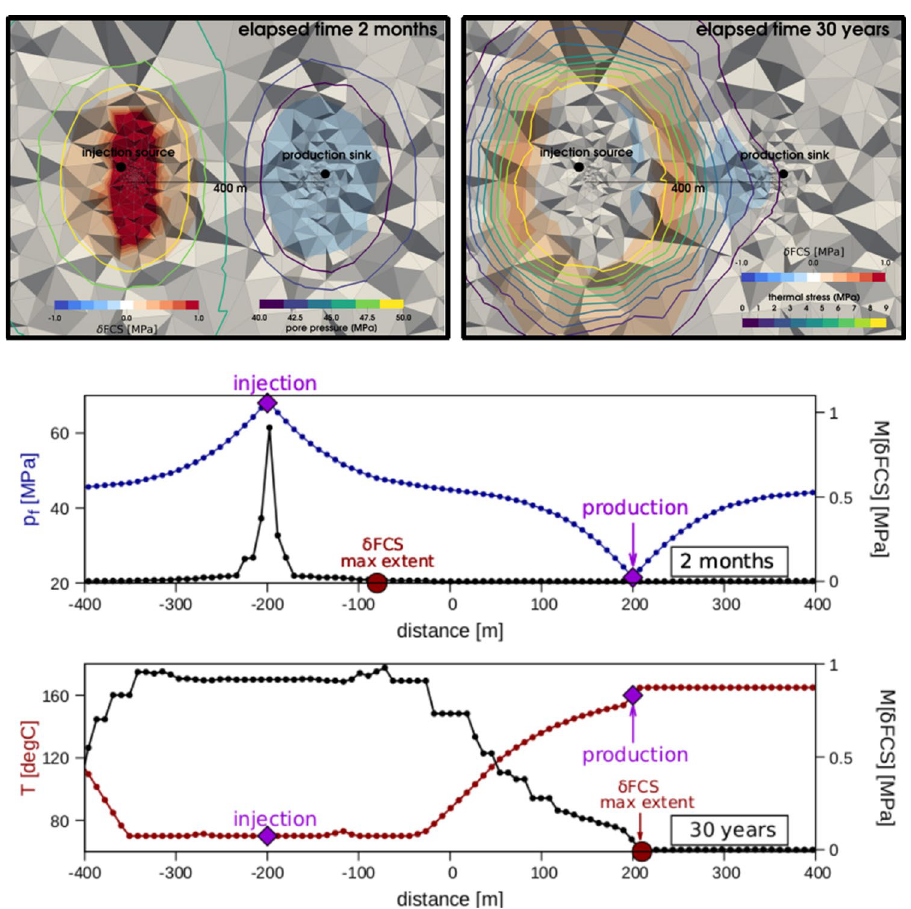
Figure 3. Thermo-poroelastic stress transfer and induced variations in FCS during long-term geothermal operations. Upper panels: computed variations in FCS for a thermo-poroelastic simulation of a 30-year continuous injection and production. Left: model results at the time when pore pressure equilibrated in the system (maximum extent of the pore pressure front). Right: model results at the final stage of the operations. Background colours indicate computed values of δ FCS , and isocountours of computed pore pressures (left panel) and thermal stresses (right panel). Lower panels: variations in computed M [ δ FCS ] extracted from the 3D model along a line passing through the injection- source and production-sink. During the early stages of the system evolution, variations in FCS are bounded by the pore pressure front and show an abrupt decay away from the injection boreole that is driven by pore pressure diffusion only. Once pressure equilibrium is reached in the reservoir, variations in FCS are driven by changes in thermo-poroelastic stresses, thereby resulting in a larger seismic footprint and a more-gradual spatial decay away from the injection